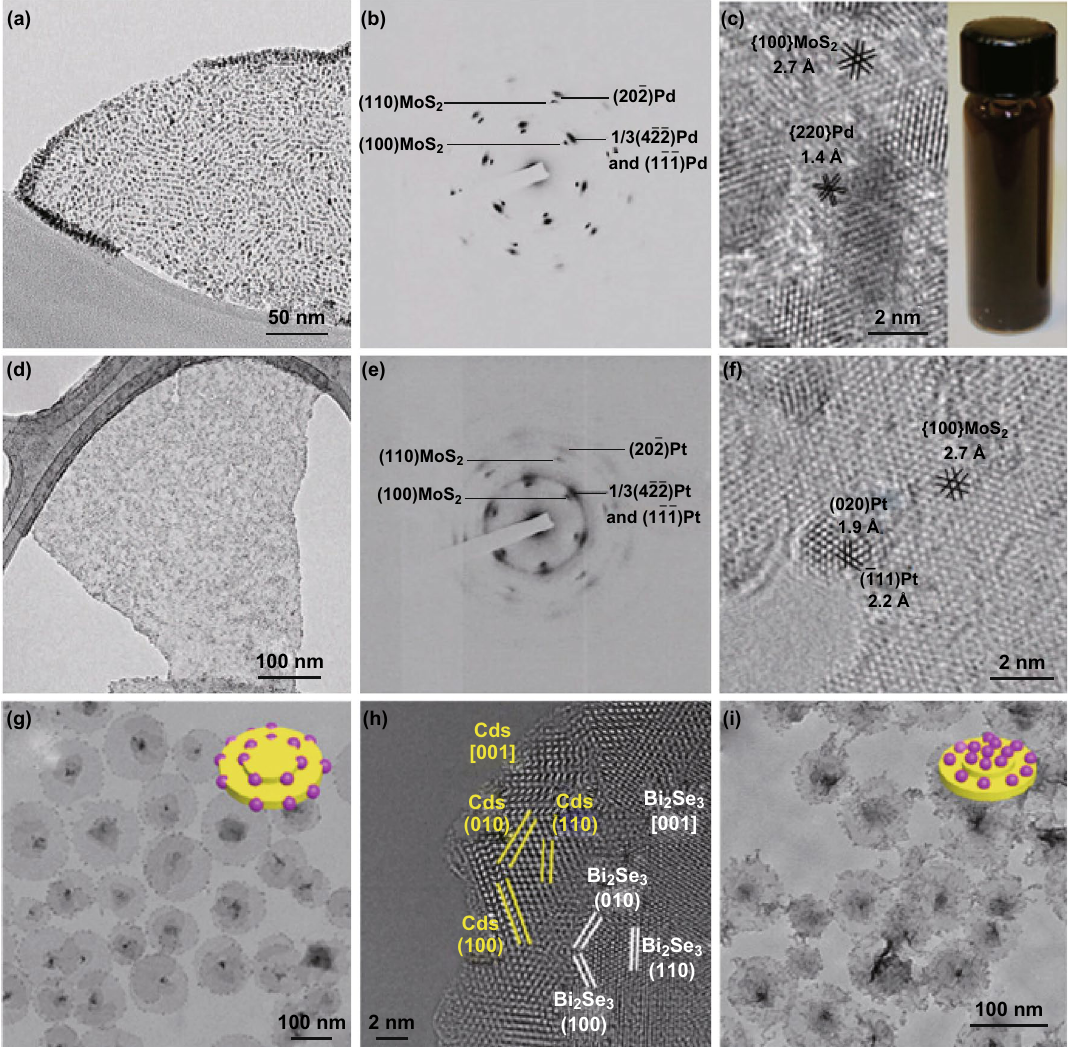
Fig. 6 a TEM image of Pd NCs grown on an MoS 2 nanosheet. b Selected‑area electron diffraction (SAED) pattern of Pd‑MoS 2 epitaxial hetero‑ structures with the electron beam perpendicular to the basal plane of the MoS 2 nanosheet. c HRTEM image of Pd NCs on MoS 2 , showing dis‑ tinguishable lattice fringes of Pd and MoS 2 . Inset: photograph of the Pd‑MoS 2 solution. d TEM image of Pt NCs grown on an MoS 2 nanosheet. e SAED pattern of Pt‑MoS 2 epitaxial heterostructures with the electron beam perpendicular to the basal plane of the MoS 2 nanosheet. f HRTEM image of Pt NCs on MoS 2 showing distinguishable lattice fringes of Pt and MoS 2 . Reproduced with permission from Ref. [24]. Copyright 2013, Nature Publishing Group. g TEM image and schematic illustration of lateral 2D heterostructures consisting of Bi 2 Se 3 nanoplates and CdS NCs. h HRTEM image of the Bi 2 Se 3 ‑CdS interface, viewed along the [001] axes. i TEM image and schematic illustration of basal Bi 2 Se 3 ‑CdS hetero‑ structures. Reproduced with permission from Ref. [140]. Copyright 2015, American Chemical